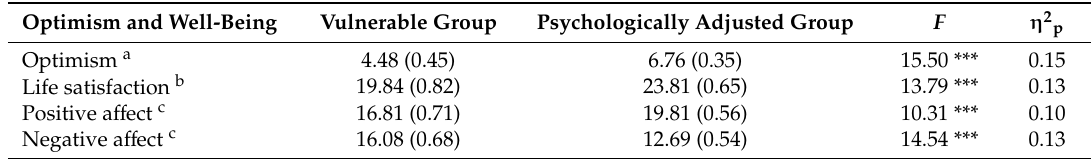
Table 4. Adjusted means (standard error in brackets) on the measures of optimism and well-being, F -statistics, and partial eta squared (time since diagnosis as